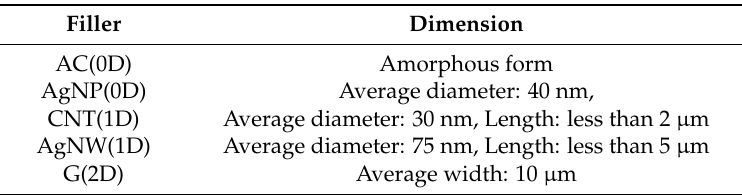
Table 1. The dimensions of fillers.